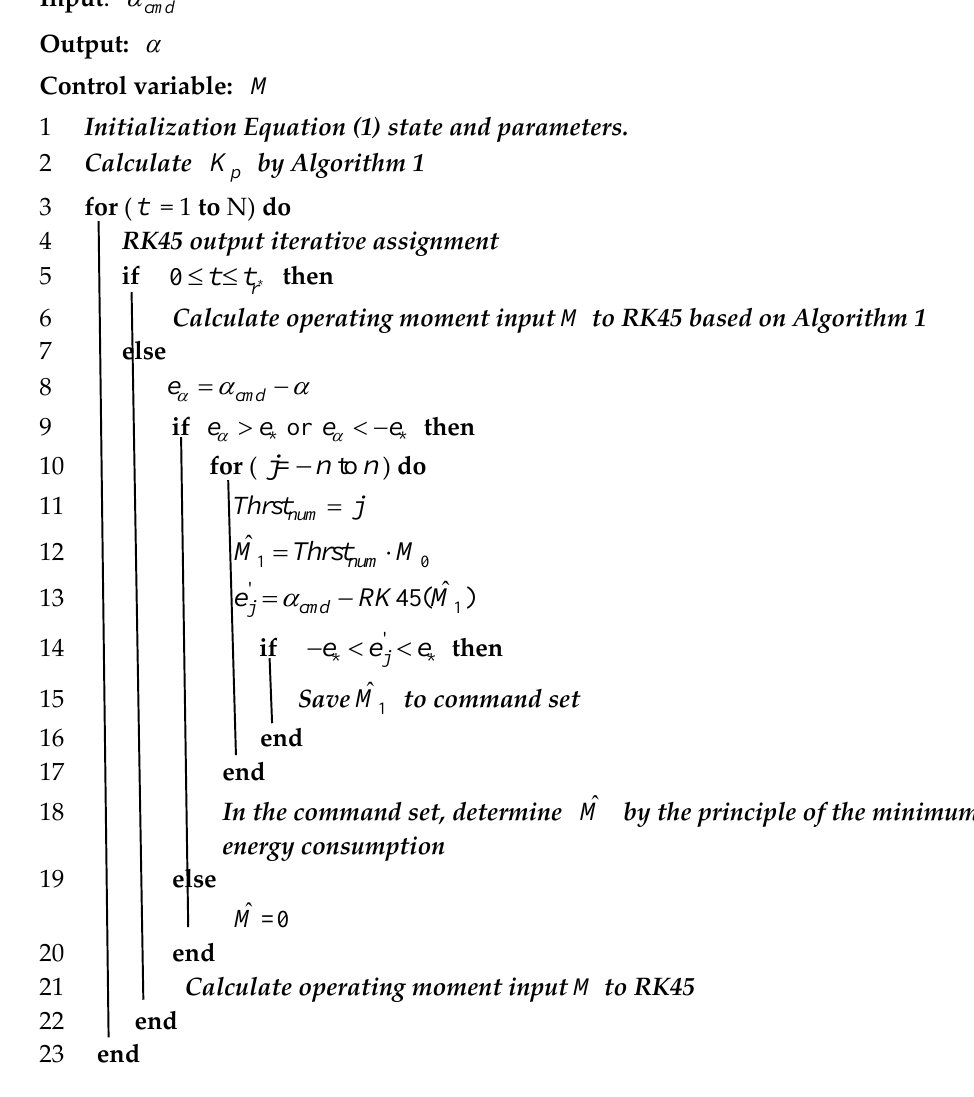
Algorithm 2: Nonlinear model-based numerical control